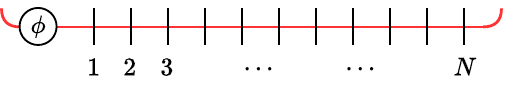
Figure 1: Graphical representation of the transfer matrix with N sites. The (cyclic) thick red line is the auxiliary space and the black lines represent the spin- 1 The twist operator is labelled by φ